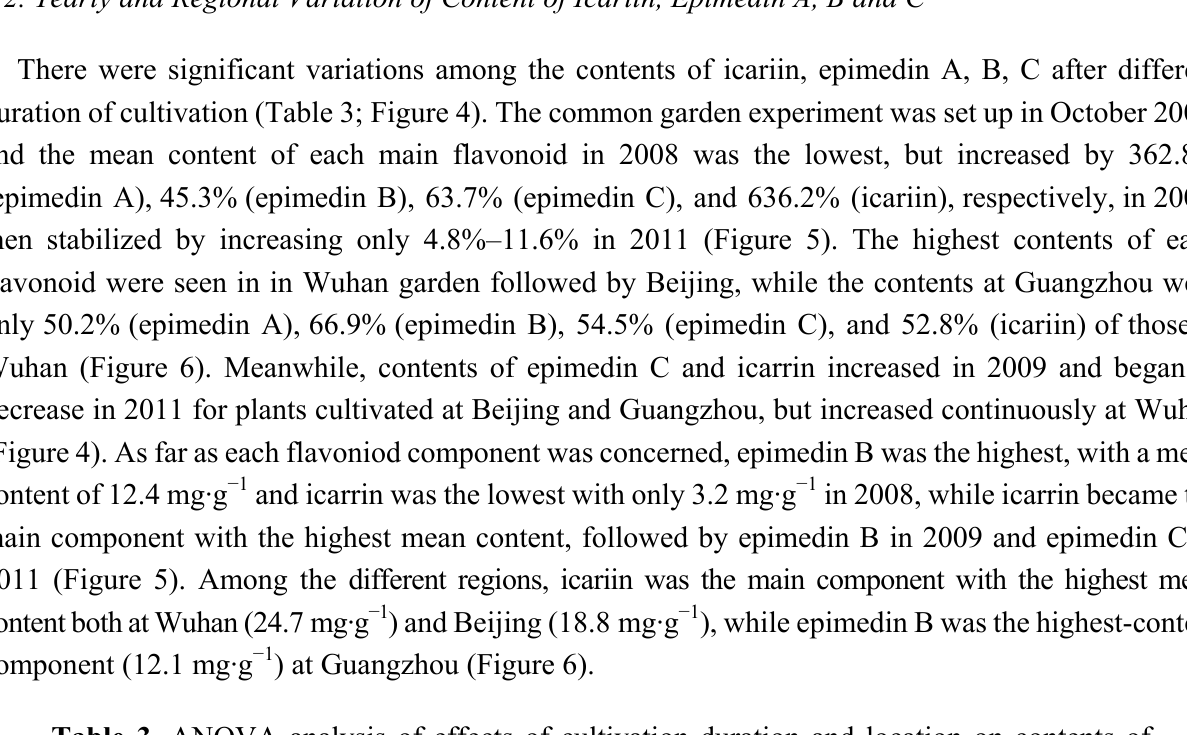
Table 3. ANOVA analysis of effects of cultivation duration and location on contents of four